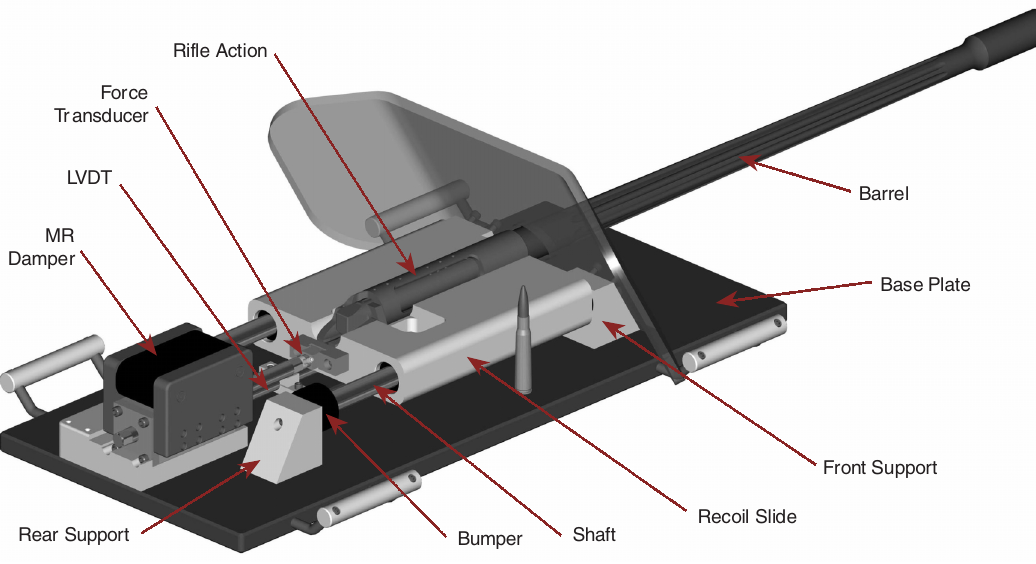
Fig. 2. Gun recoil demonstrator assembly.